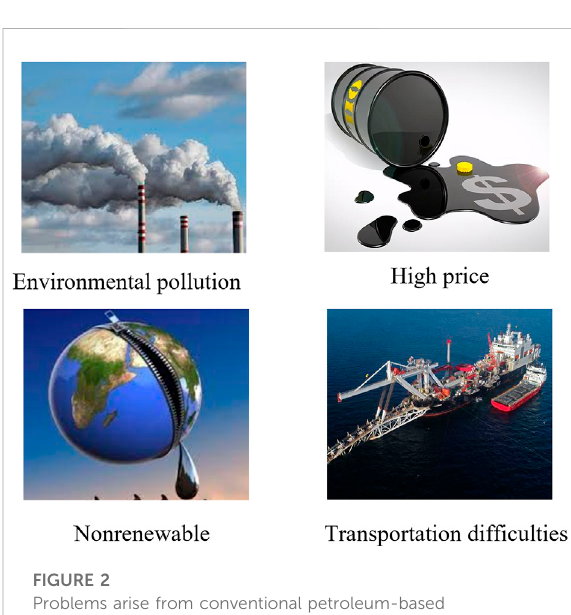
FIGURE 2 Problems arise from conventional petroleum-based synthetic fi ber.